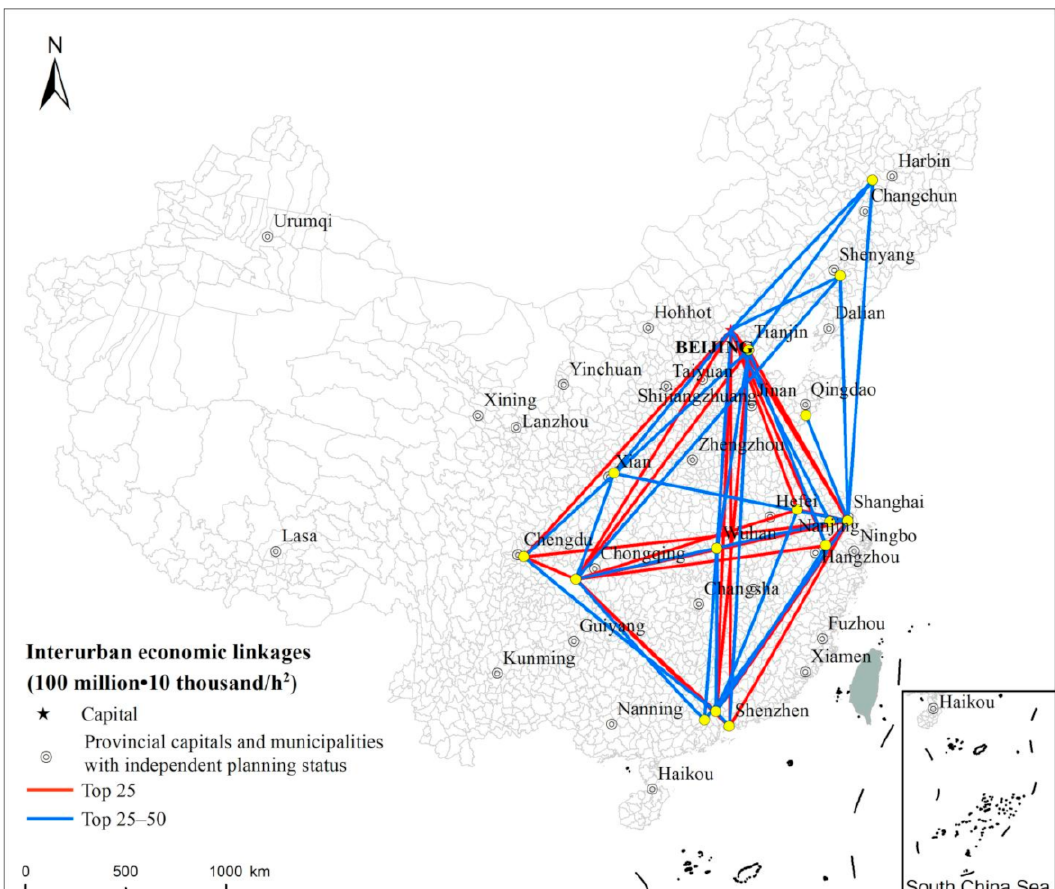
Figure 6. Spatial distribution of the top 50 cities ranked by interurban economic connection in China. Based on mobile signal and OD data from China Unicom in 2018, we characterized the urban network spatial connection and structure using the gravity model [39]. The spatial characteristics also conformed to the “diamond” distribution and were consistent with the conclusion of this study (Figure 7). Therefore, the research results of various data sources have shown that the characteristics of urban network spatial connection and structure in China are not limited by data selection, revealing that China’s urbanization has entered the era of urban agglomeration and metropolitan circle. Promoting the development of